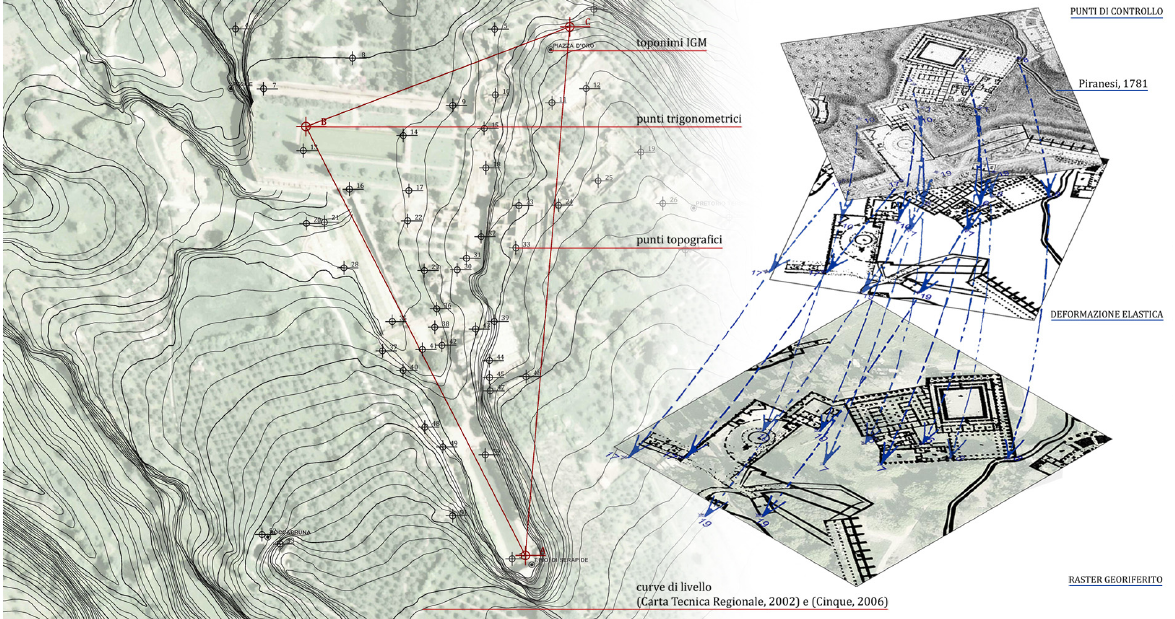
Figure 3. New investigation methods using